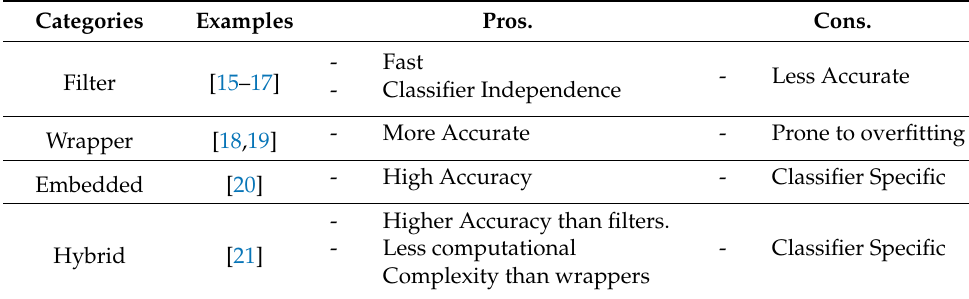
Table 1. Categories of the feature selection